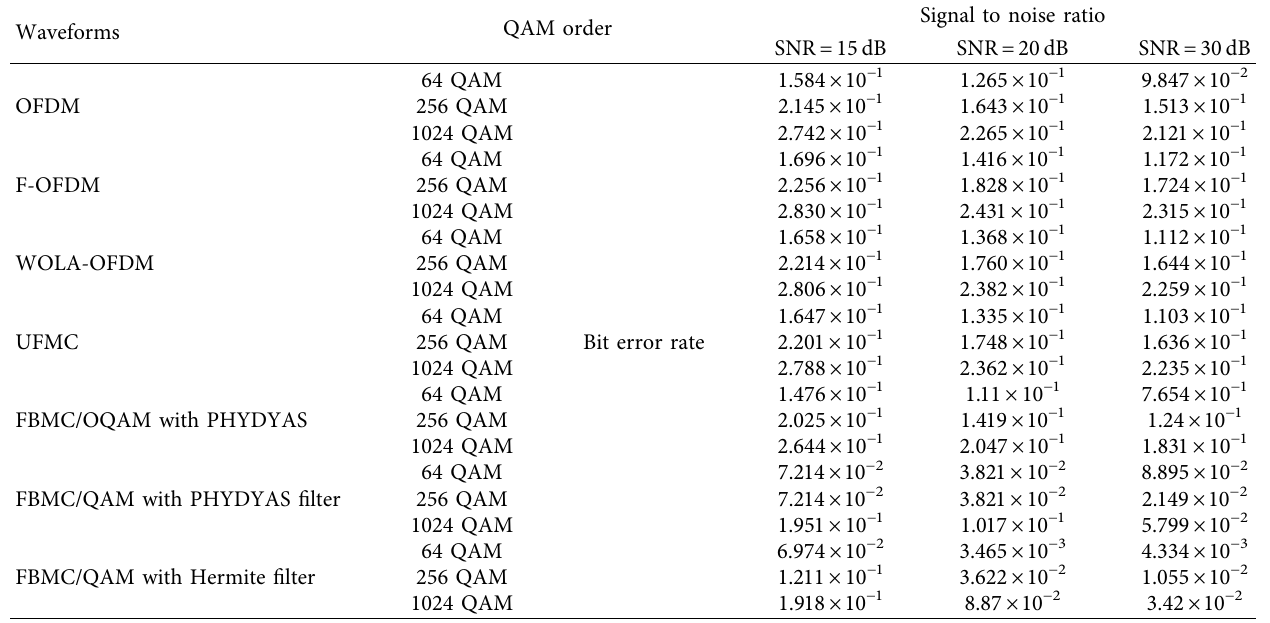
Table 4: Bit error rate performance of multicarrier modulation techniques with 64 QAM, 256 QAM, and 1024 QAM for Vehicular B channel model.